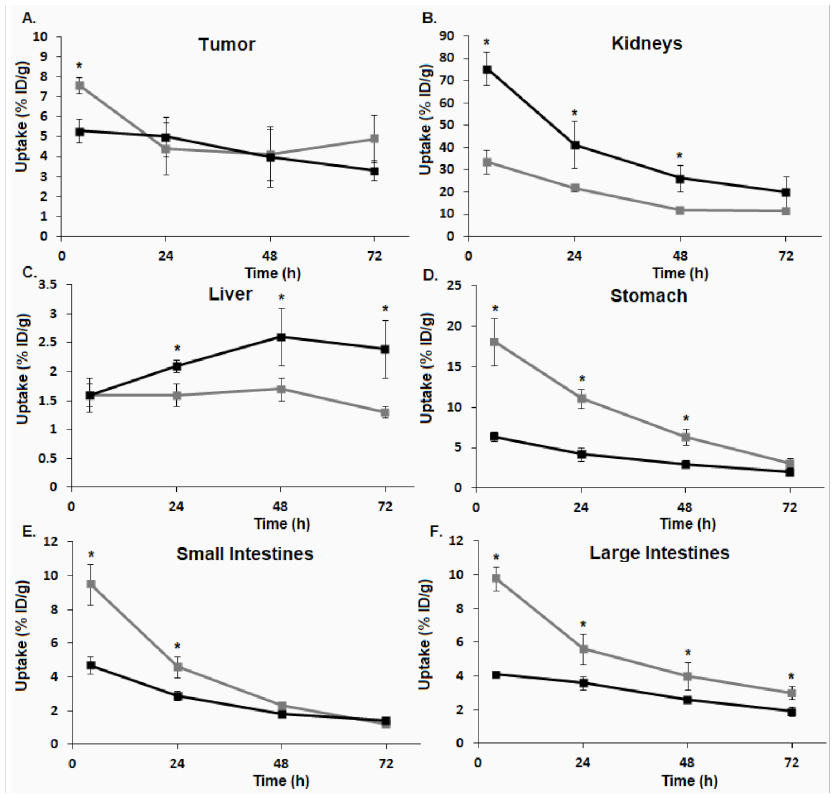
Figure 3. ( A ) Binding to human and mouse serum ( n = 3/compound/condition; bars: SD). ( B ) Stabil- ity in human serum at 37 °C. ( C ) Stability in mouse serum at 37 °C for [ 64 Cu] 1 ( ■ ) and [ 64 Cu] 2 ( ■ Figure 4. Biodistribution time activity plots for [ 64 Cu] 1 ( (cid:4) ) and [ 64 Cu] 2 (